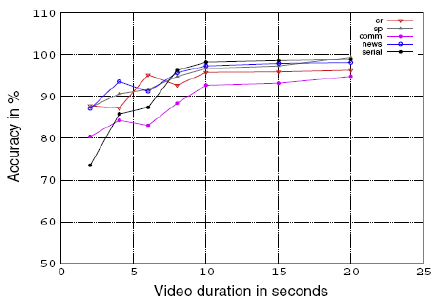
Fig. 6 BICC with HMM for different duration